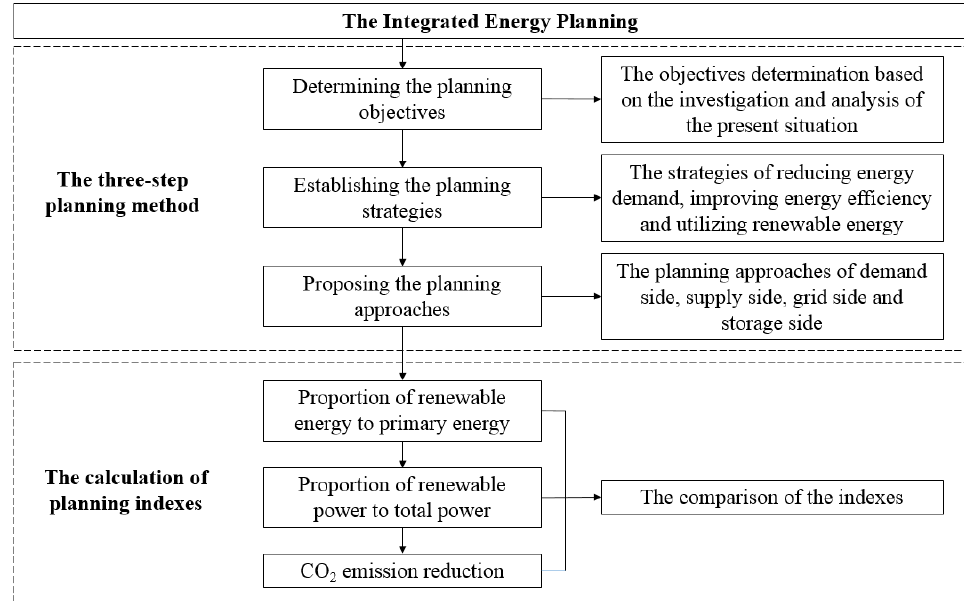
Figure 2. The three-step planning method process.